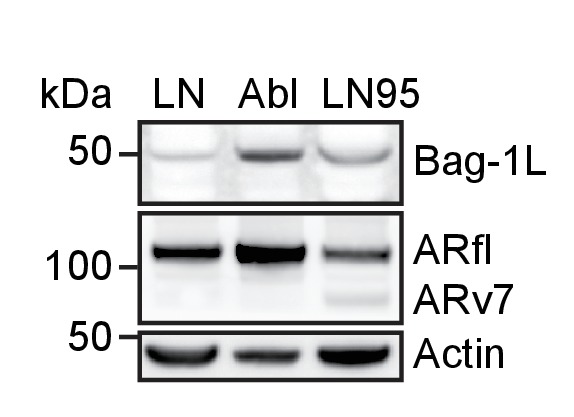
Western blot comparison of endogenous Bag-1L levels in PCa and CRPC lines.Endogenous Bag-1L levels, as determined by an antibody against Bag-1, in hormone-dependent LNCaP (LN) cells and in the CRPC lines LNCaP-abl (Abl) and LNCaP95 (LN95). AR levels and equal protein loading are shown, utilizing anti-AR and -actin antibodies, respectively.